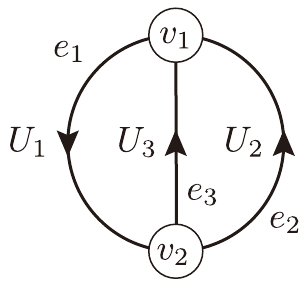
Figure 3. An example of the